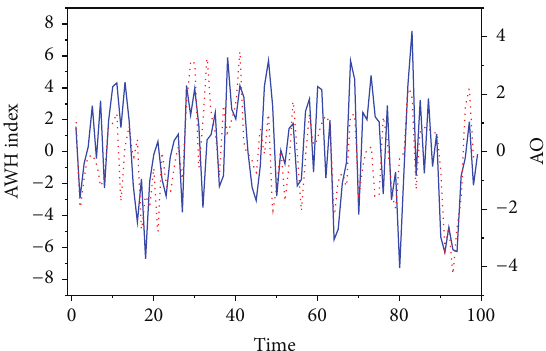
Figure 6: The variation of AWH index and AO monthly index in winter time. The blue line is AWH and the red dotted line is